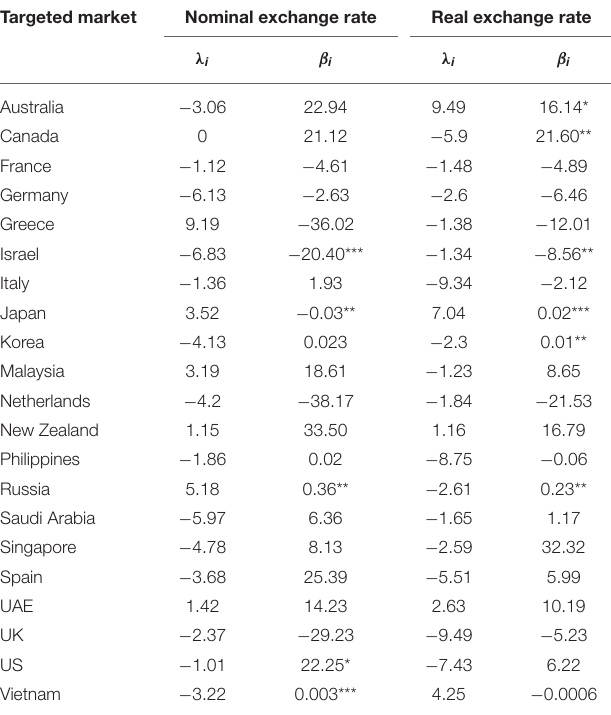
TABLE 2 | Chinese medical products’ (HS: 902000) market power status in different countries.